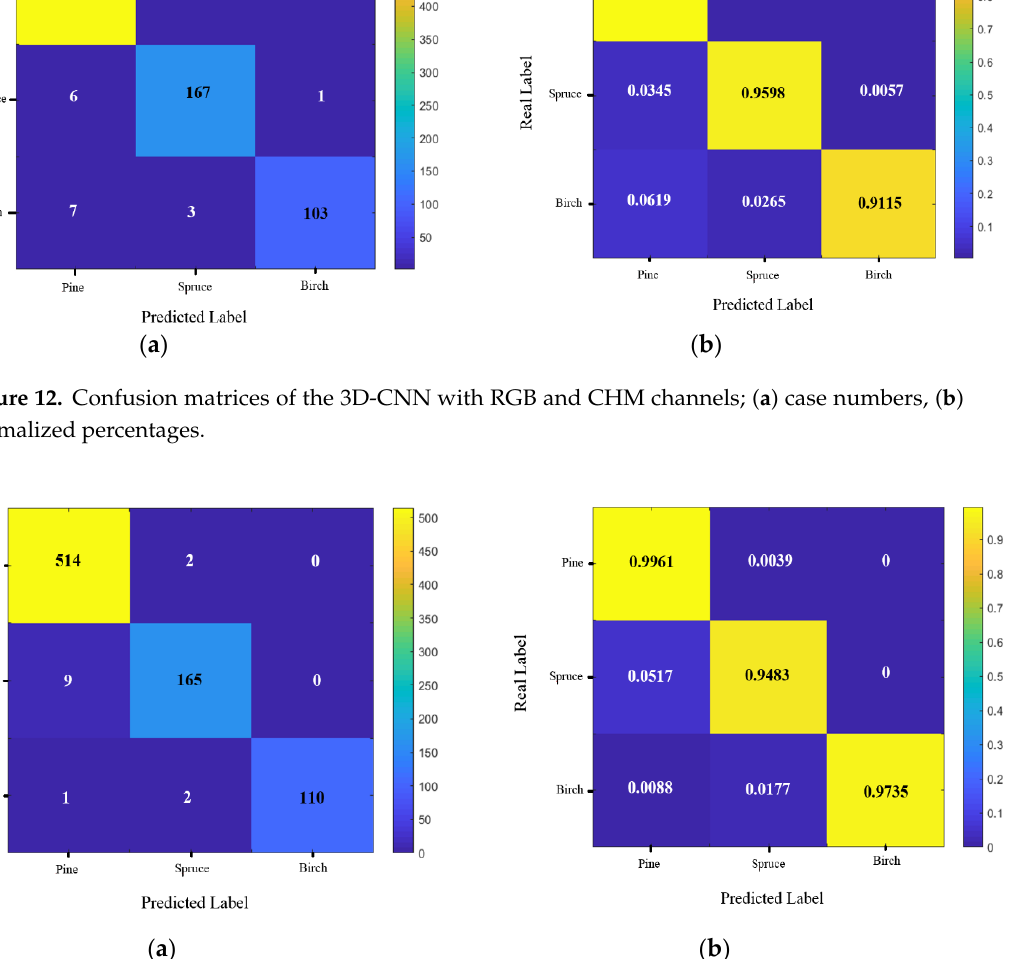
Figure 13. Confusion matrices of the 3D-CNN with RGB and spectral channels ; ( a ) case numbers, ( b ) normalized percentages.